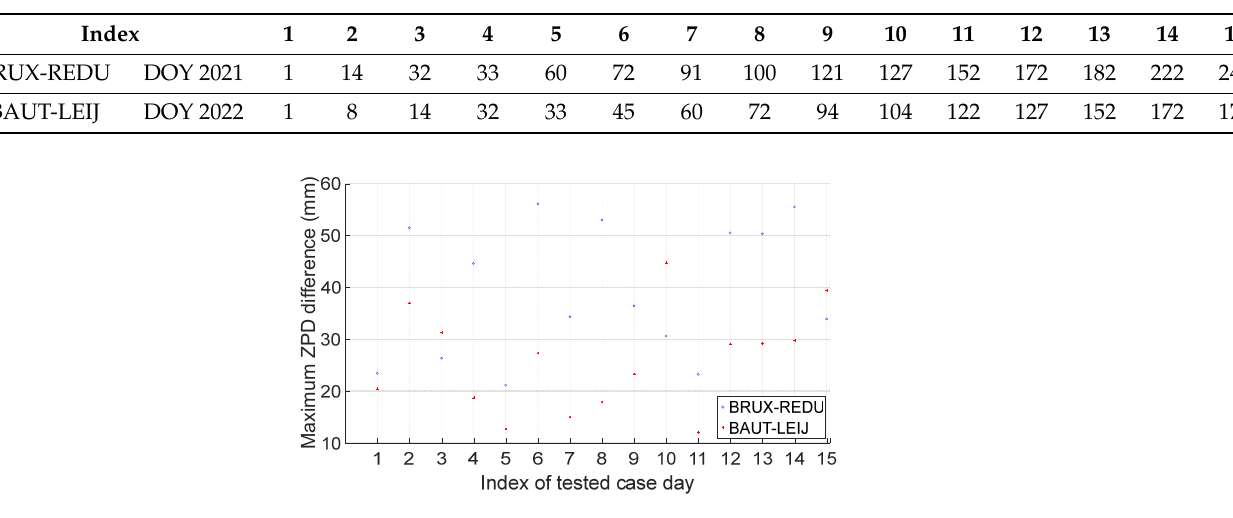
Figure 13. ZPD difference between BAUT and LEIJ. Table 12. Tested case day (day of year).